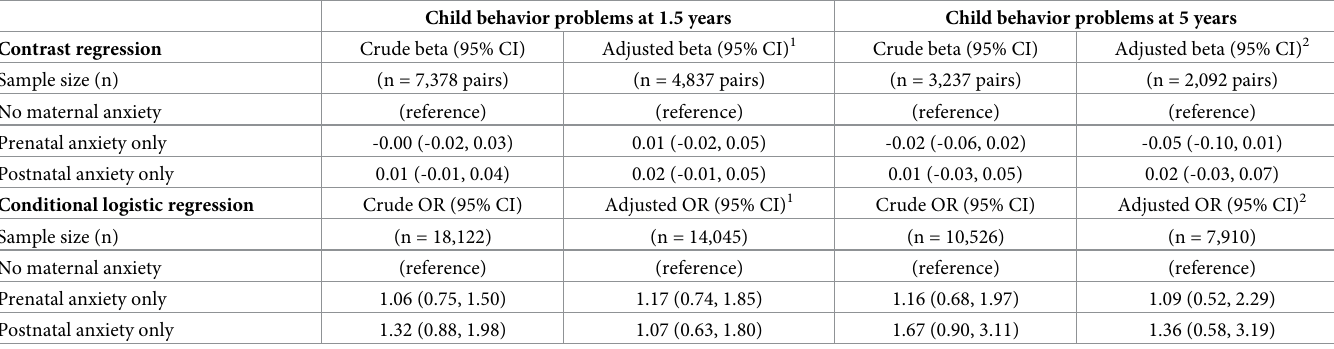
Table 5. The effect of maternal anxiety on child behavior problems at 1.5 and 5 year (sibling